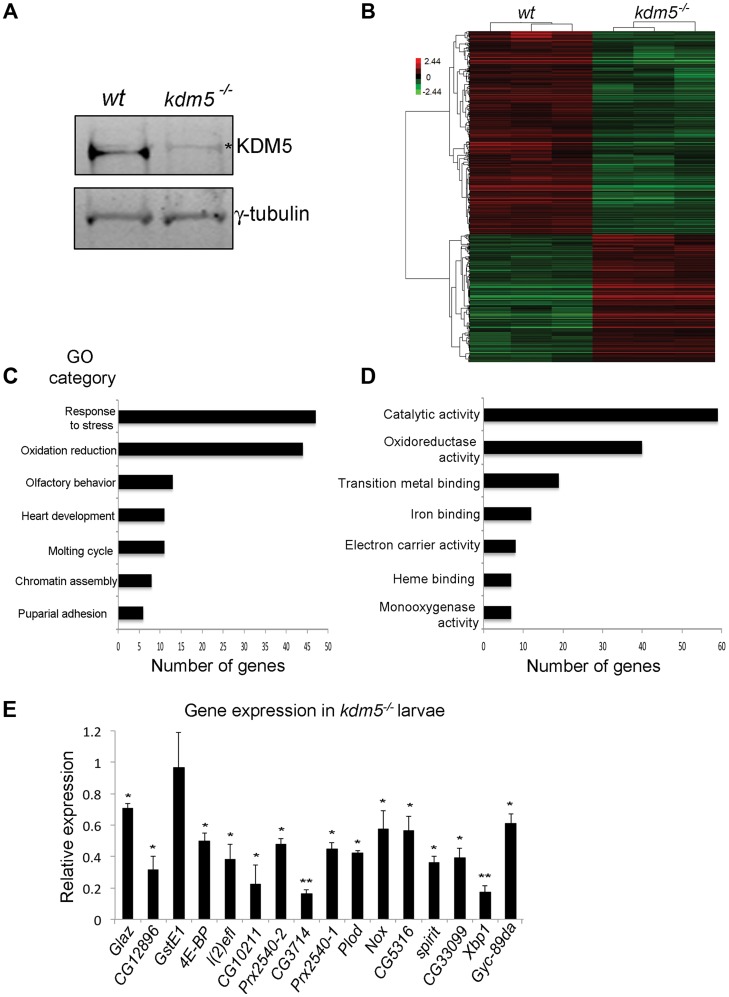
KDM5 mutants show reduced expression of genes required to reduce oxidative stress.A) Western blot showing levels of KDM5 and the loading control γ-tubulin in wildtype (w1118) and kdm510424 homozygous mutant wing imaginal discs used for microarrays. * indicates a non-specific band. (B) Hierarchical clustering analysis of 901 genes that are differentially expressed 1.5-fold or more in kdm5 mutant wing discs compared to wildtype (w1118) (p<0.05). Up-regulated genes are shown in red; down-regulated genes in green. (C) Gene ontology analyses showing biological process enrichment analysis of down- and up-regulated genes (p≤0.01). (D) GO David analyses of the Molecular function of the 84 stress response and oxidation reduction class genes (p≤0.01). (E) Real-time PCR showing levels of oxidative stress response genes in kdm510424/K6801 3rd instar female larvae relative to wildtype. Levels of gene expression within each sample were normalized to rp49 and shown relative to wildtype. * p<0.05, ** p<0.01.